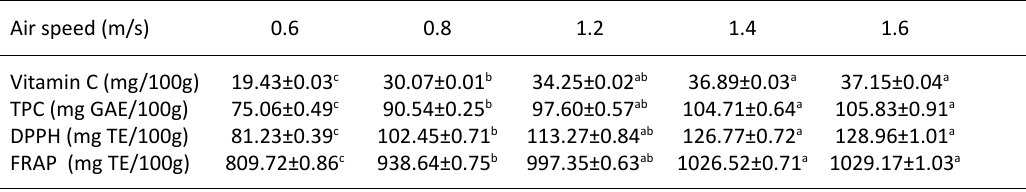
table 6. Impact of air speed in microwave-air dehydration to phenolic content and antioxidant capacity in dried flower Air speed (m/s)